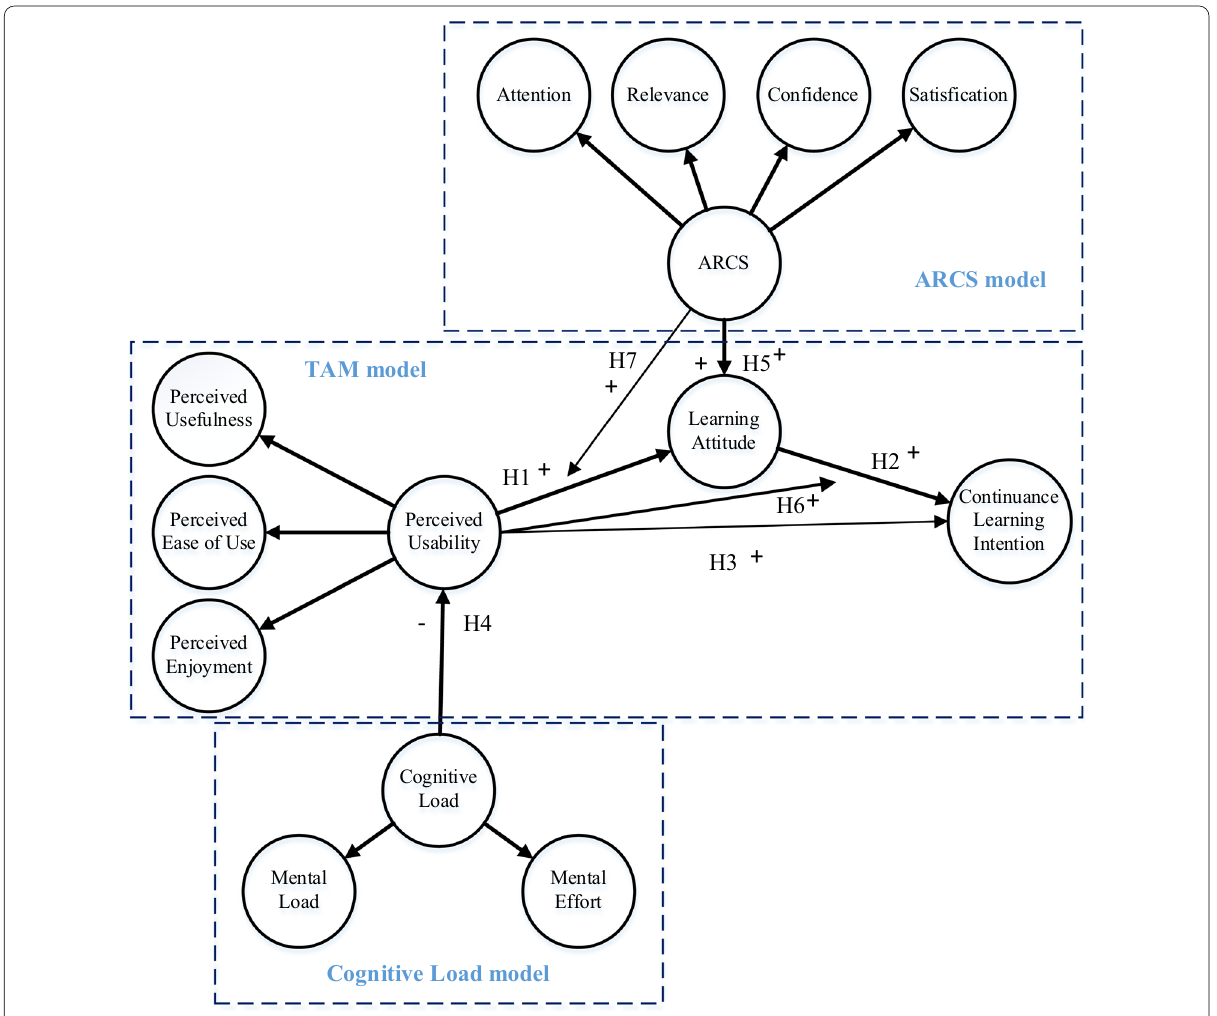
Fig. 3 Conceptual research